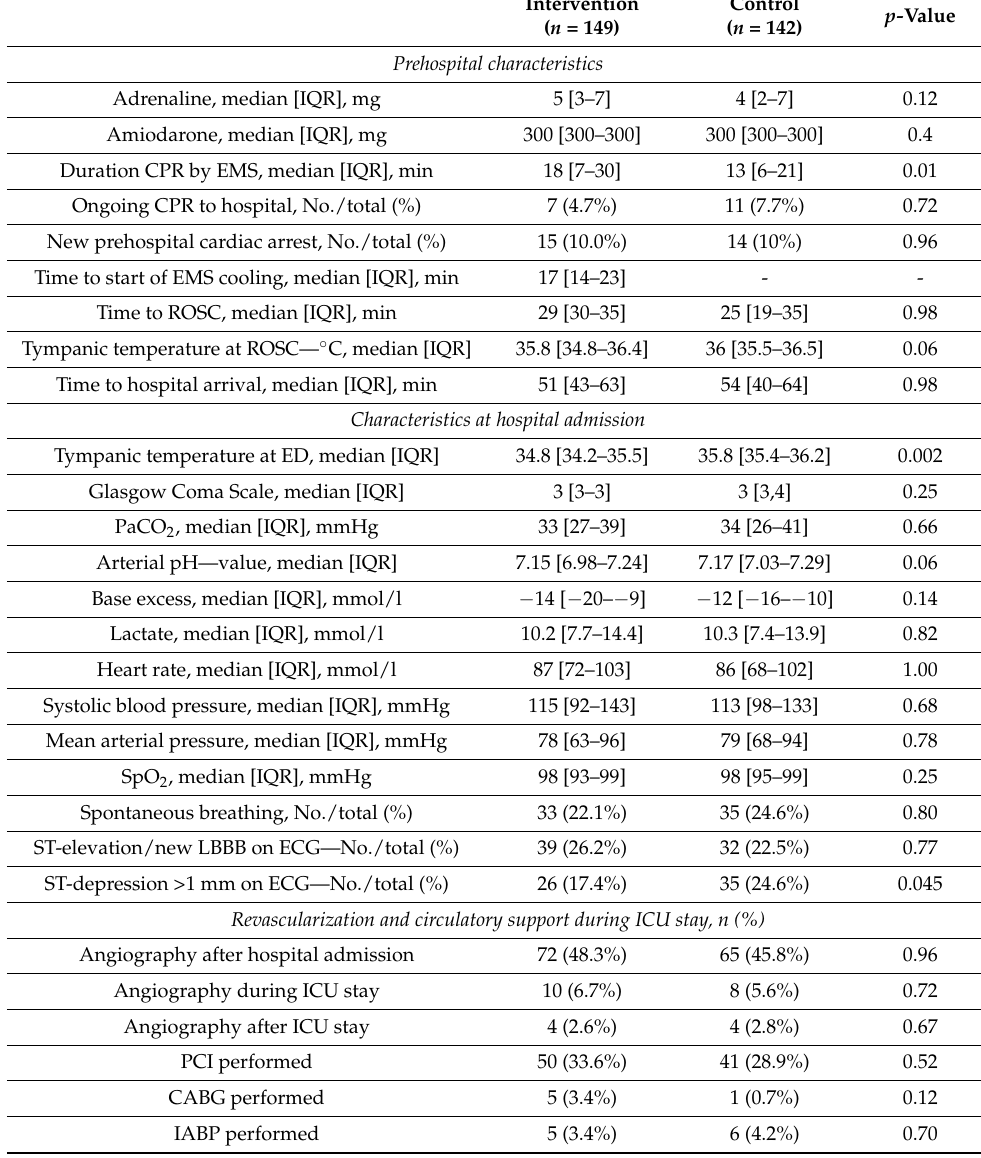
Table 2. Post-randomization characteristics and measures, according to the trial arm assignment. Data are reported as median [IQRs] or count (%). CABG = coronary artery bypass; IABP = intra- aortic balloon counter-pulsation; ED = emergency department; EMS = emergency medical system; LBBB = left bundle branch block. “New prehospital cardiac arrest” indicated re-arrest while not yet at the